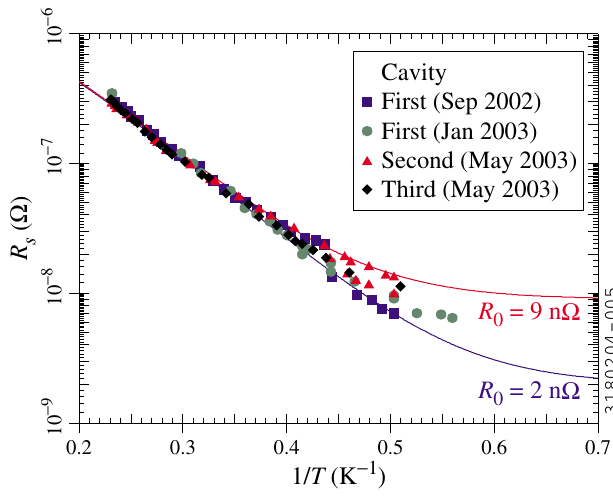
FIG. 8. (Color) Measured dependence of the rf surface resist- ance on bath temperature for the 6-cell cavity prototypes. The solid lines are theoretical predictions for C 2 or 9 n(cid:17) .